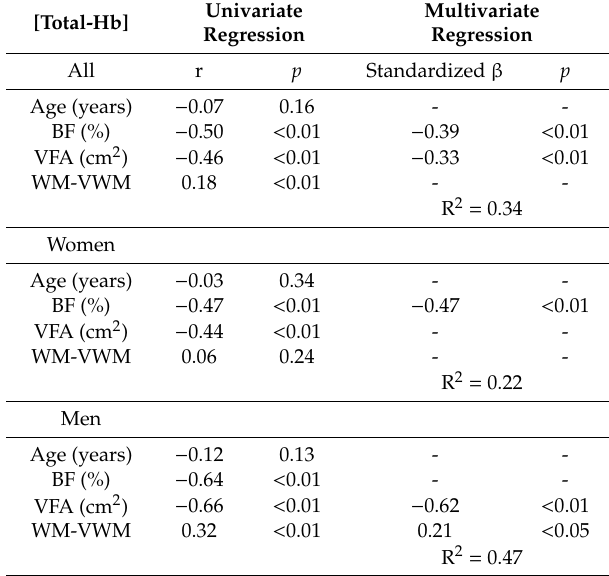
Table 4. Multiple regression analysis with [Total-Hb] in the supraclavicular region as an independent variable. Univariate Multivariate [Total-Hb] Regression